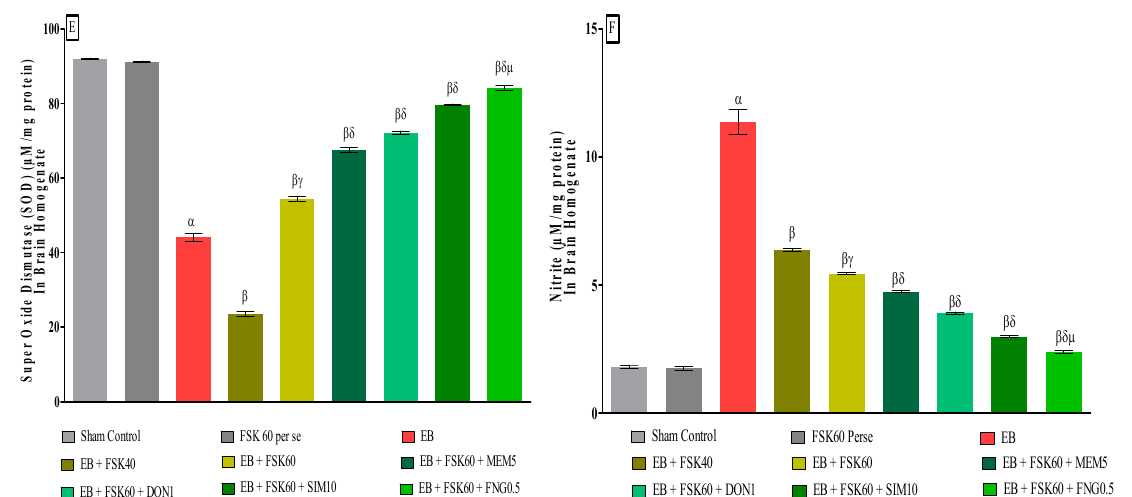
Figure 12. ( A – F ): Protective role of FSK on reduction in oxidative stress levels in experimental multiple sclerosis rats. Analysis of Variance (ANOVA) with Tukey’s test was used to evaluate the data, which were presented as mean with SD ( n = 6). α EB (p < 0.01) v / s Sham control and FSK40 perse; β EB + FSK40, EB + FSK60, EB + FSK60 + MEM5, EB + FSK60 +